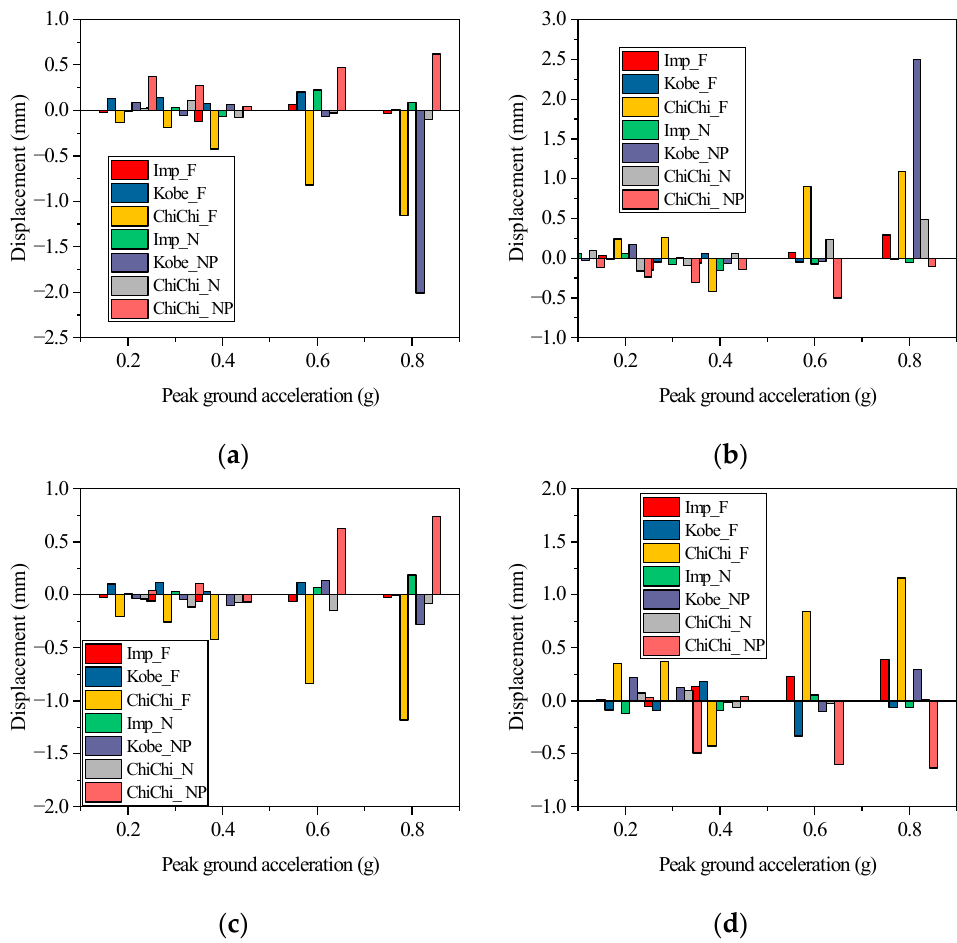
Figure 15. Residual displacement of the viscous dampers: ( a ) Northeast location; ( b ) Southeast location; ( c ) Northwest location; ( d ) Southwest location.